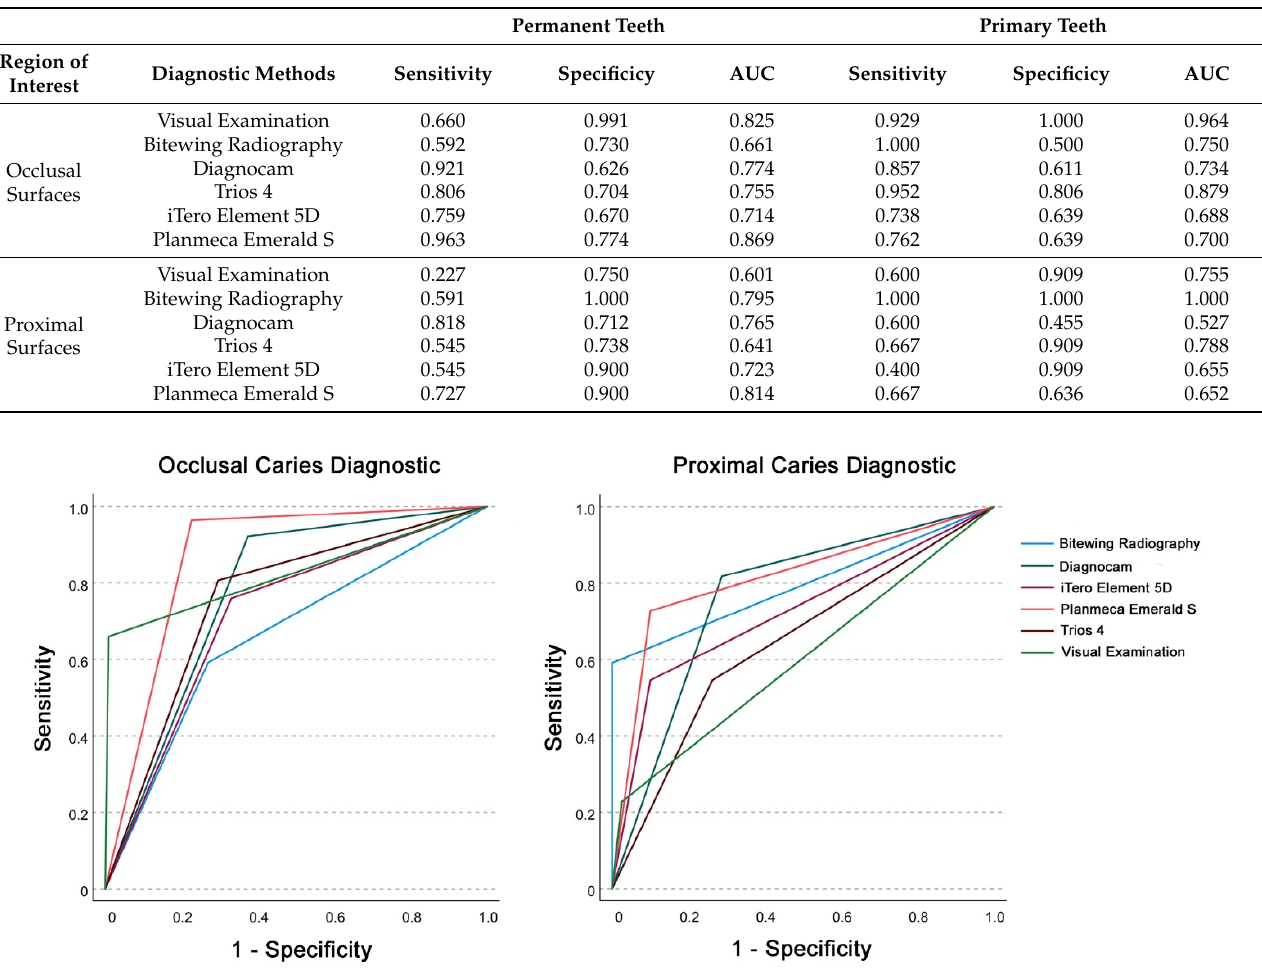
Table 1. Caries diagnostic methods regarding sensitivity, specificity, and area under curve (AUC) values with receiver operating characteristic (ROC) curve analysis for threshold I (sound (0)) versus overall caries (pooled data of enamel (1) and dentin caries (2)).